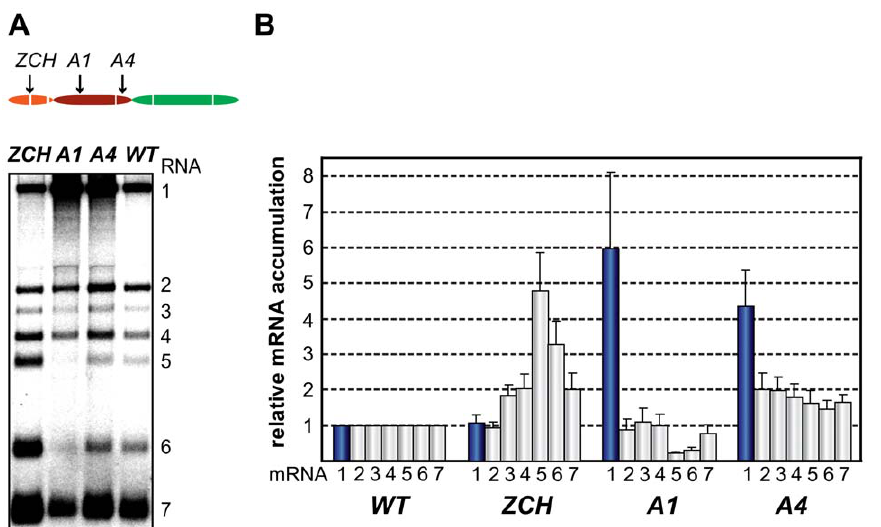
Figure 4. Multiple mutations in nsp1 exert species-specific effects on viral mRNA accumulation. (A, B) Gel hybridization analysis and quantification of EAV-specific mRNA accumulation in cells transfected with the ZCH, A1, A4 mutant or a wt control. (A) Viral mRNA accumulation was analyzed at 11 h post-transfection by gel hybridization as described in the legend to Fig. 3. (B) The accumulation levels of each viral mRNA in the nsp1 mutants were quantified by phosphorimaging in the linear range of exposure and normalized to the level of accumulation of each corresponding viral mRNA in the wt control, which was set at 1. Genomic RNA levels are represented as blue bars. The relative values correspond to the means from three independent transfections and error bars denote standard